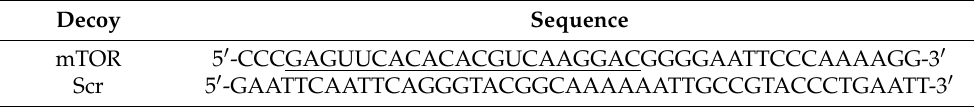
Table 1. Sequences of the ODNs used in this study. The target site of the mTOR RNA sequence is underlined. Decoy Sequence mTOR Scr mTOR, mammalian target of rapamycin; Scr, scrambled; ODNs, oligonucleotides.